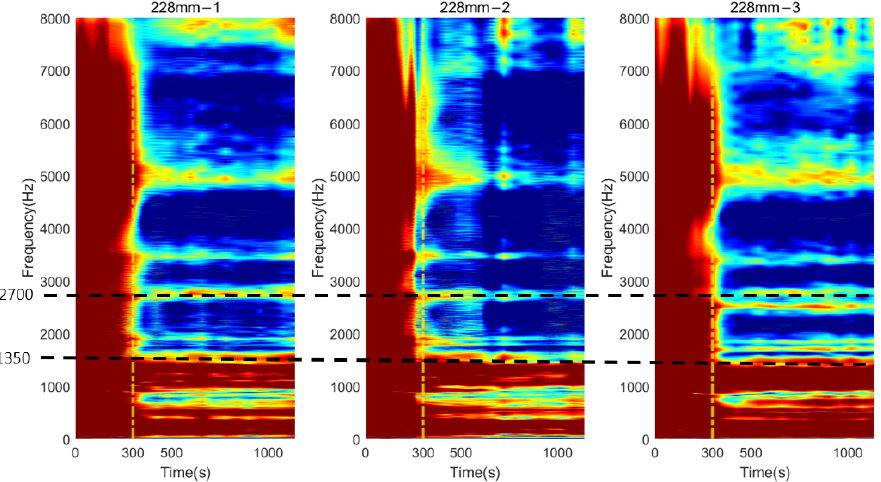
Figure 13. Colormap of the normalised magnitude development as a function of cure time for 228 mm.